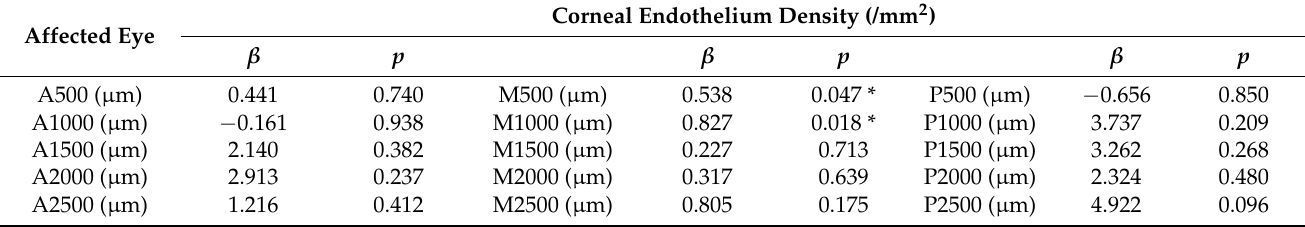
Table 2. Univariate linear regression of associations of iris thickness and corneal endothelium density in PSS-affected eyes.